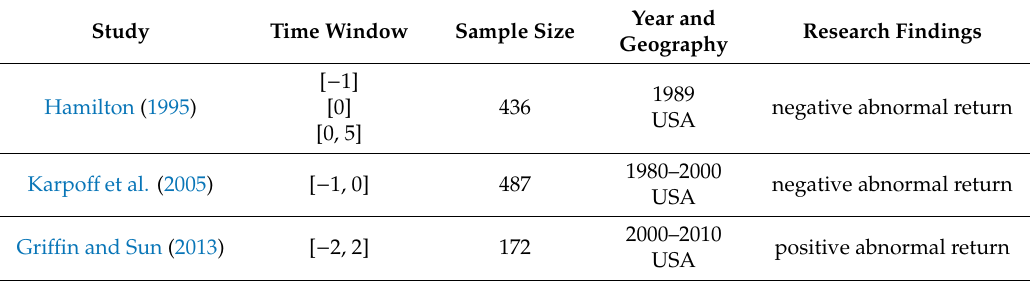
Table 1. Event studies in the category environment.